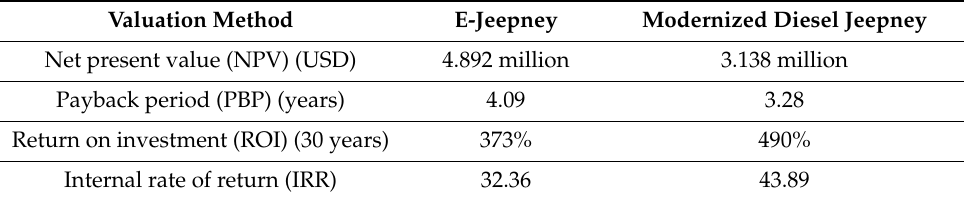
Table 1. Financial estimation results using traditional valuation